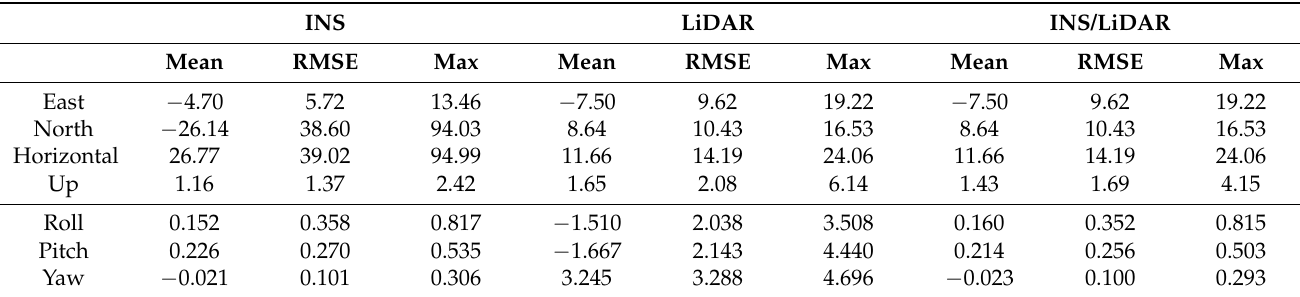
Table A14. D-64—position (m) and attitude (deg) error statistics.